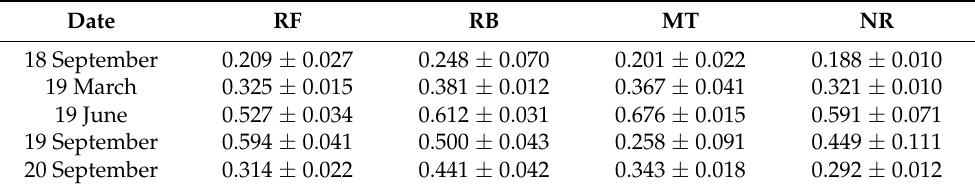
Table A2. The mean AWCD at 96 h in different treatments from 2018 to 2020.